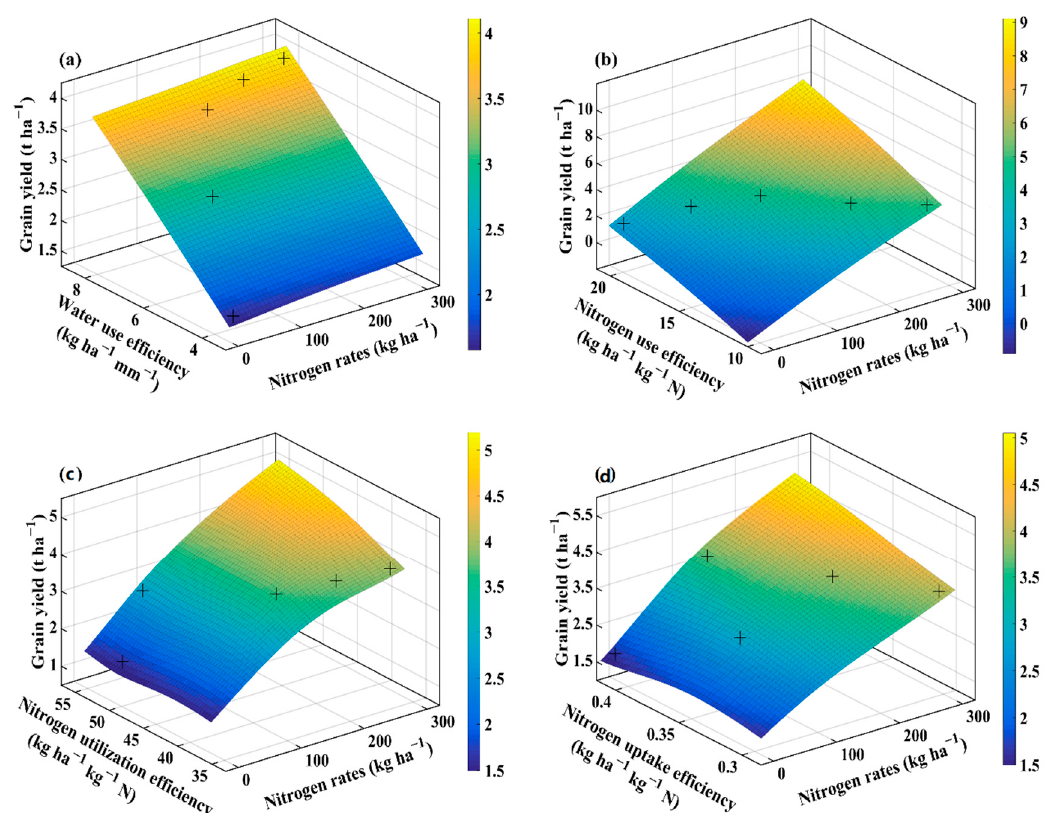
Figure 5. Thin plate smoothing spline plots showing the interaction of N rates ( x -axis) with water use efficiency, nitrogen use efficiency, nitrogen utilization efficiency, and nitrogen uptake efficiency ( y -axis) on average grain yield ( z -axis) in the 2013–2014 growing season. The various panels show water use efficiency ( a ); nitrogen use efficiency ( b ); nitrogen utilization efficiency ( c ); and nitrogen uptake efficiency ( d ) for the 2013–2014 growing season, respectively. + indicates the observed data.